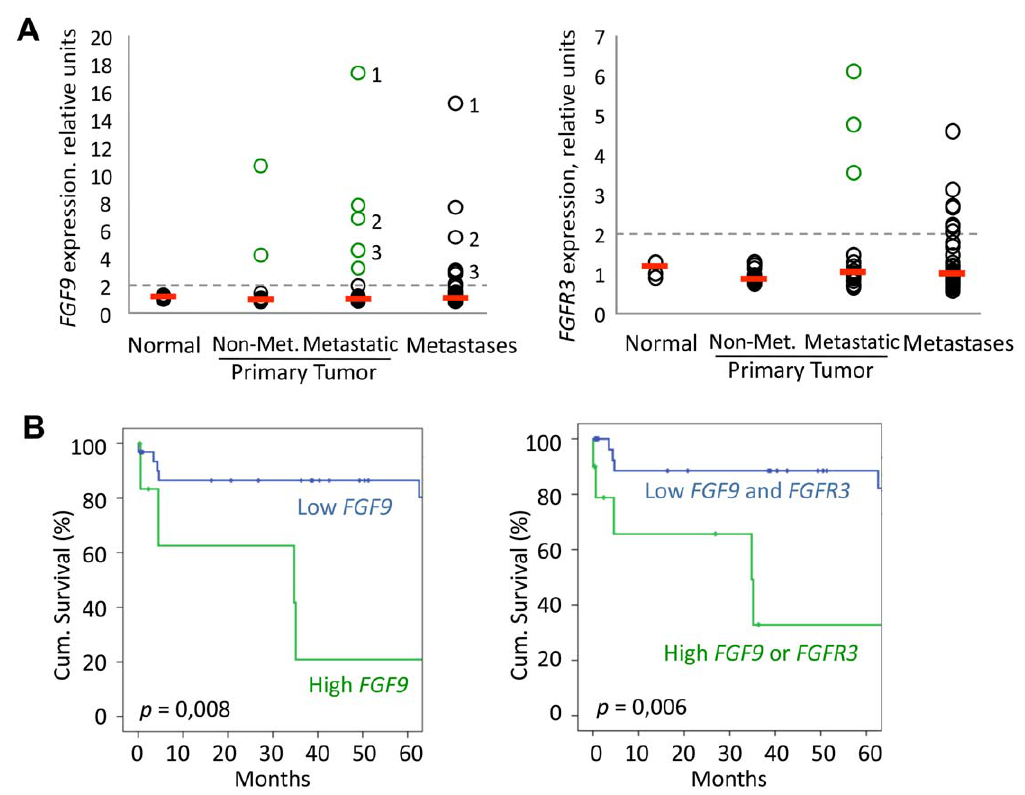
Figure 7. FGF9 expression in colon carcinoma correlates with patients’ survival. A Expression of FGF9 or FGFR3 in invasive and metastatic colon carcinoma, as assessed by microarray analysis (n=95). Expression in each sample is indicated by circle, median expression in each group is given by red bar. Numbers in FGF9 graph indicate primary tumor/metastasis pairs derived from the same patient. B Kaplan-Meier survival analysis of patients examined in A (primary tumors with follow-up data only, n=39). Patients were grouped according to high ( . 2-fold of median, indicated by green circle in Fig. 7A) and low FGF9 and FGFR3 expression.